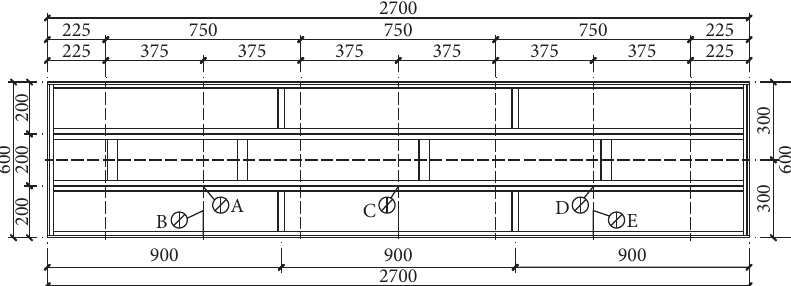
Figure 9: Arrangement of the measuring points of deflection on the three-span continuous